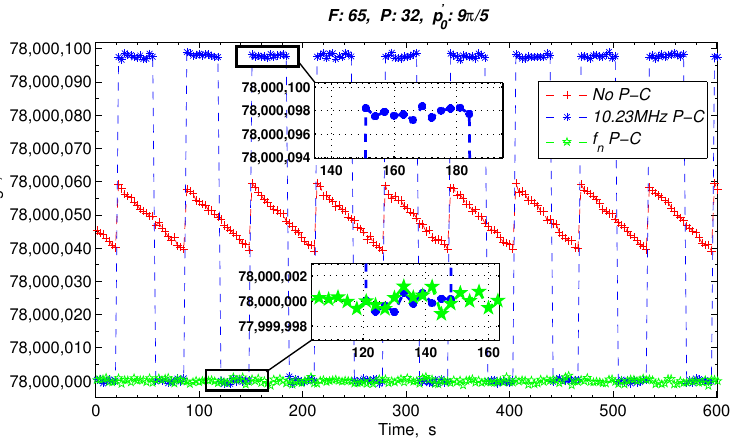
Figure 9. Ranging results with the 1 PPS in the